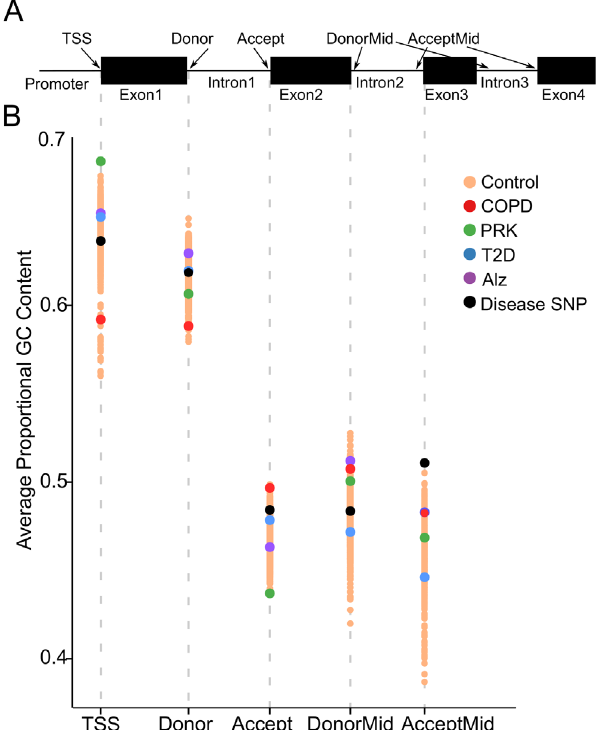
Fig 4. COPD splice junctions have lower GC content than expected. (A) Diagram of a representative gene with the regions of interest labeled, including the transcription start site (TSS), the first donor splice site (Donor), the first acceptor splice site (Accept) and the subsequent internal donor and acceptor splice sites (DonorMid and AcceptMid). (B) We calculated the average GC content for the 60 nucleotides surrounding each region in COPD-associated genes as well as genes associated with other diseases (PRK, T2D and ALZ). As a comparison, we also analyzed the GC content of genes with disease-associated SNPs within the TSS or splice junctions (black dots).